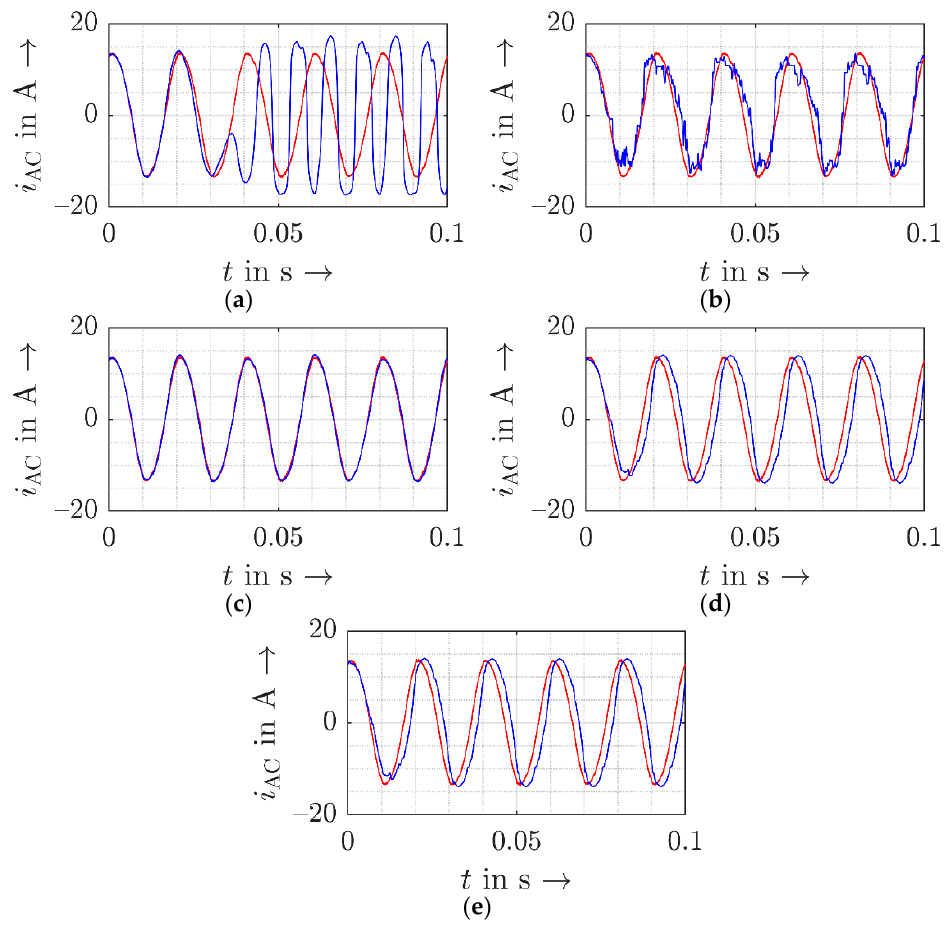
Figure 4. Measured grid-side current (red) and grid-side current simulated by the artificial neural network (ANN) (blue) for ( a ) Momentum, ( b ) RMSprop, ( c ) Nesterov Accelerated Gradient (NAG), ( d ) Nesterov Accelerated Adaptive Moment Estimation (Nadam) and ( e ) Adaptive Moment Estimation (Adam) after 25 epochs.